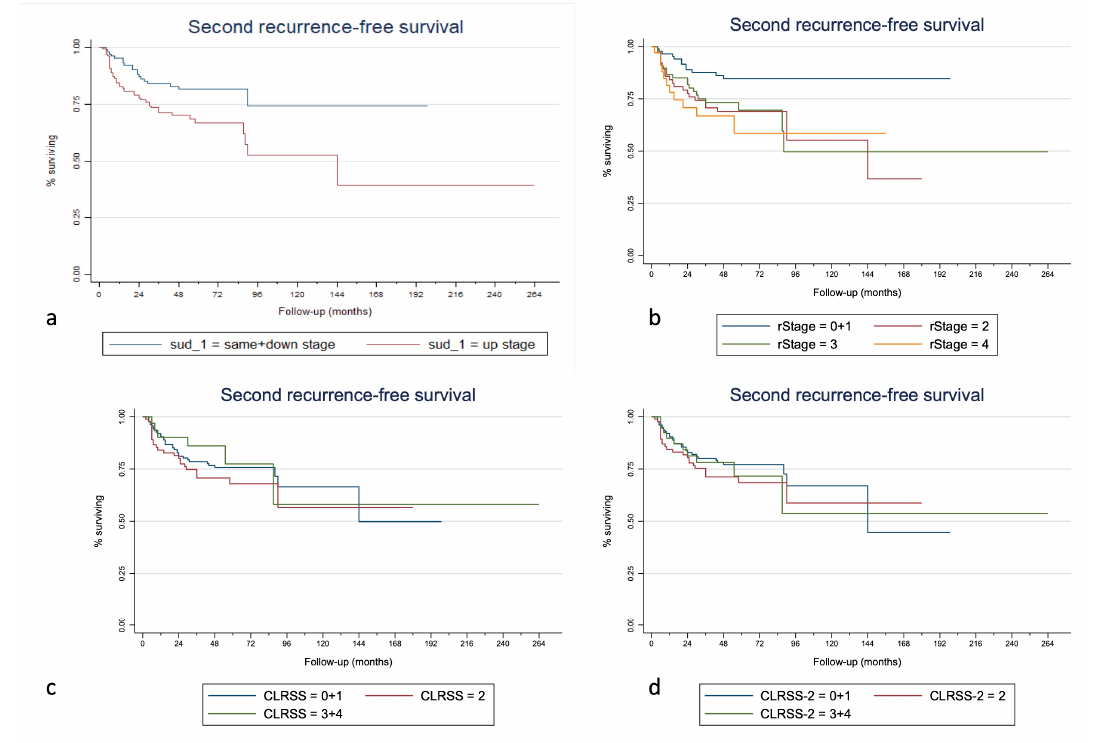
Figure 2. Kaplan–Meier curves for second-recurrence-free survival stratified for the SUD ( a ), rTNM